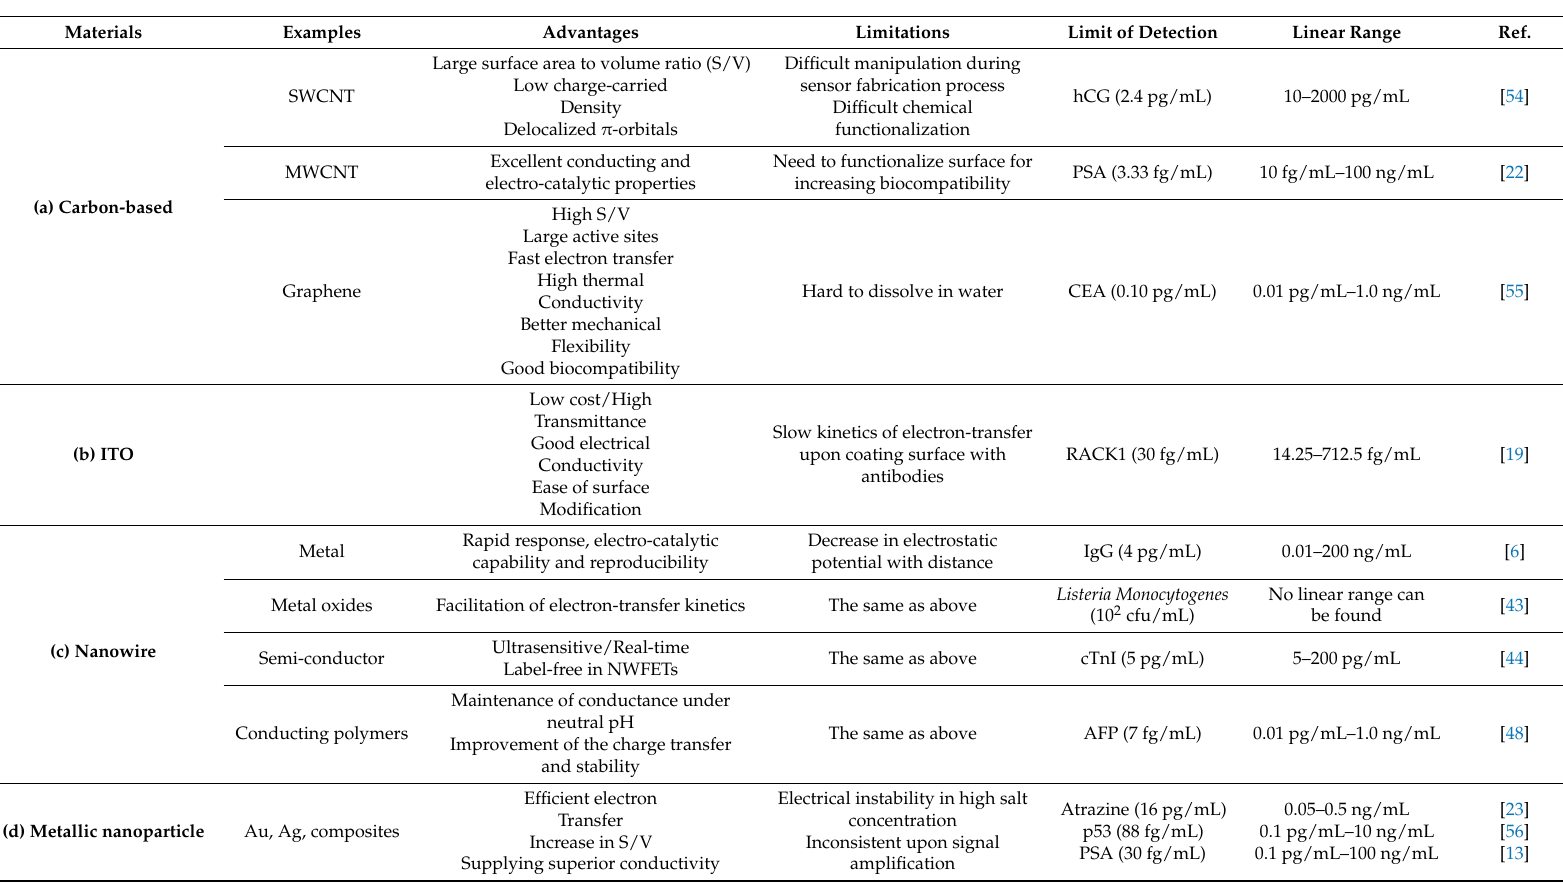
Table 1. Summary of representative nanomaterials used as electrode scaffolds for signal enhancement. Abbreviation: Single-wall carbon nanotube